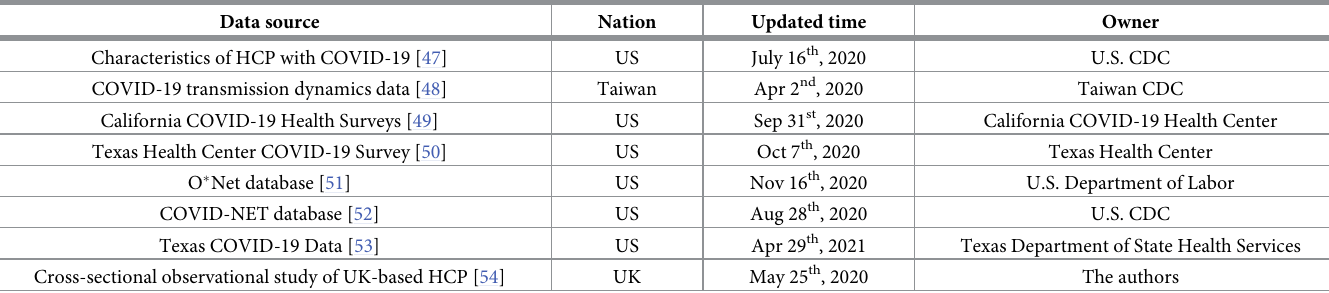
Table 1. Sources of databases information including source, nation, updated time, and